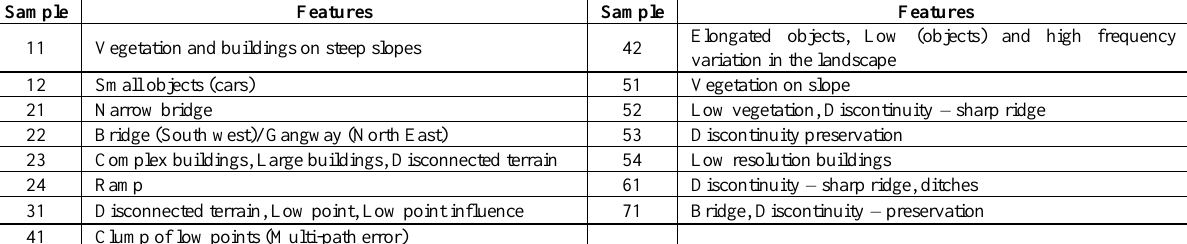
Table 1. Sample data for testing algorithm